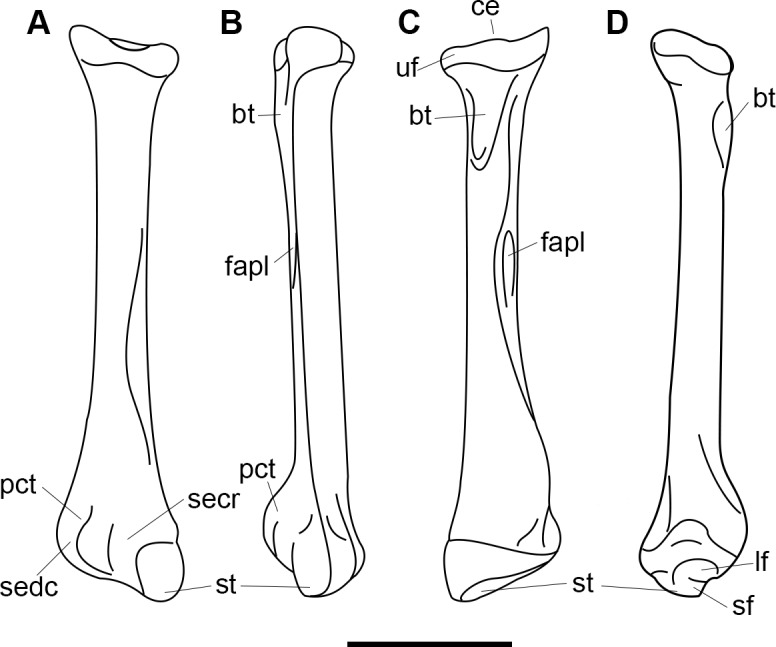
Annotated line drawing of the right radius of Periptychus carinidens.(A) anterior view; (B) lateral view; (C) posterior view; (D) medial view. Abbreviations: bt, bicipital tuberosity; ce, capitular eminence; fapl, fossa for the abductor pollicis longus; lf, lunate facet; secr, sulcus for the extensor carpi radialis; sedc, sulcus for the extensor digitorum communis; sf, scaphoid facet; st, styloid process; uf, ulnar facet. Scale bar: 30mm.